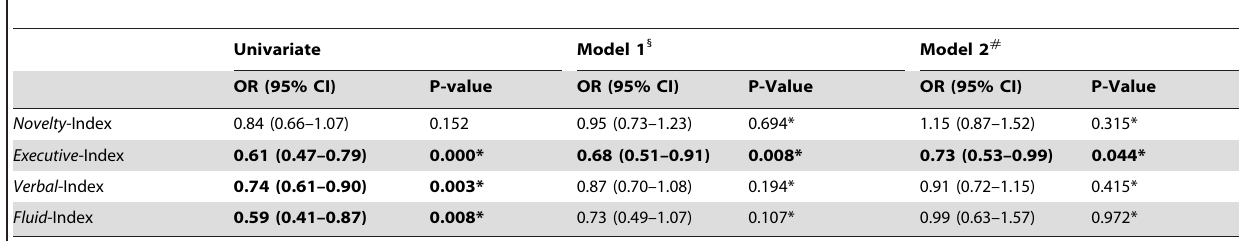
Table 2. Logistic Regression Models of the association between the occupational context indices and the incidence of dementia in individuals 75 years and